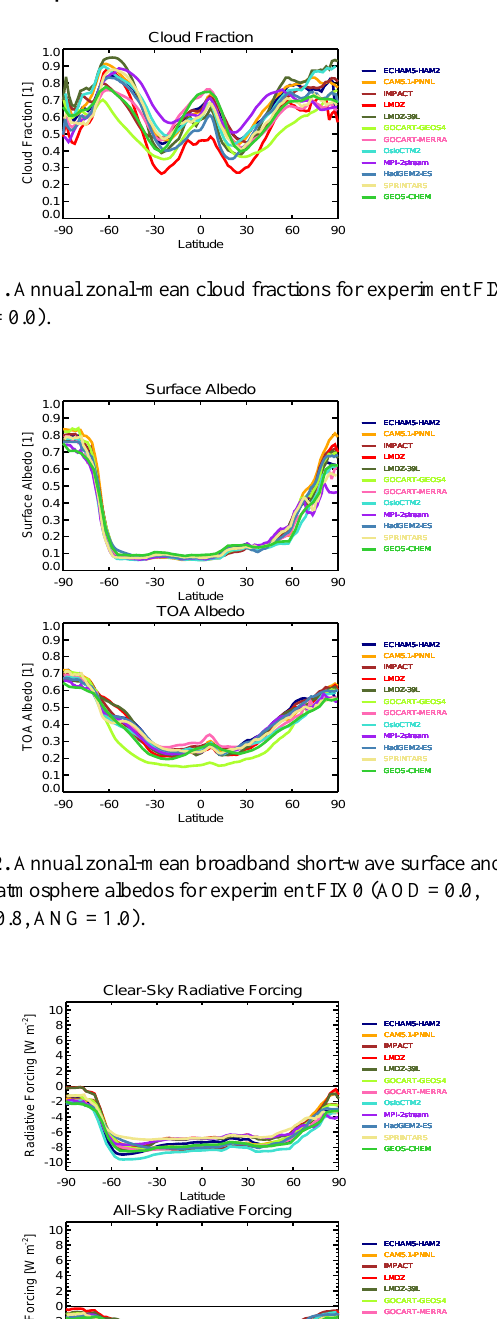
Fig. A5. Annual zonal-mean short-wave clear-sky and all-sky top-of-atmosphere radiative forcing between experiments with AOD=0.2 and AOD=0.0 distributed over the lowest two kilometers, holding SSA=0.8 and ANG=1.0